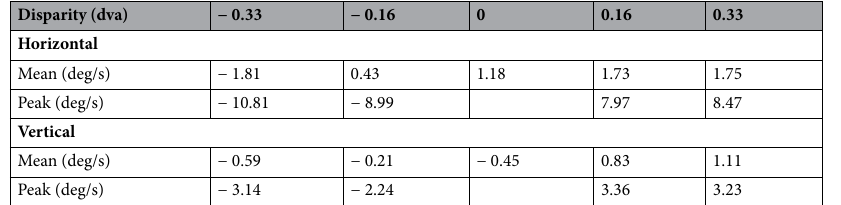
Table 1. Summary of vergence velocity ( n = 29). Mean velocities were the averaged values over the period during which significant correlations were found between disparity and vergence velocity in each of the horizontal and vertical conditions. Peak velocities in the negative and positive disparity conditions were the group mean of the minimal and maximal values within the significant period, respectively. The averaged SE over the disparity conditions was 1.42 and 1.49 deg/s for mean and peak velocities,